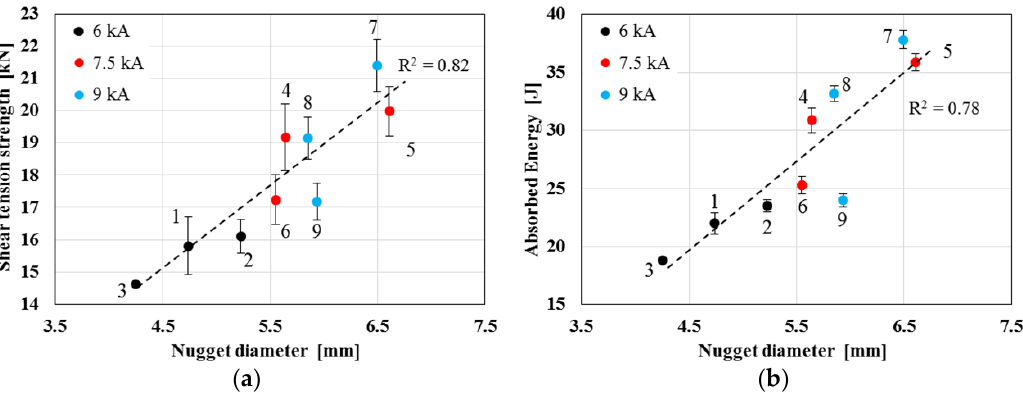
Figure 9. ( a ) Shear tension strength and ( b ) absorbed energy of the spot welds for the different welding conditions. The numbers in the graph refer to the experimental runs.